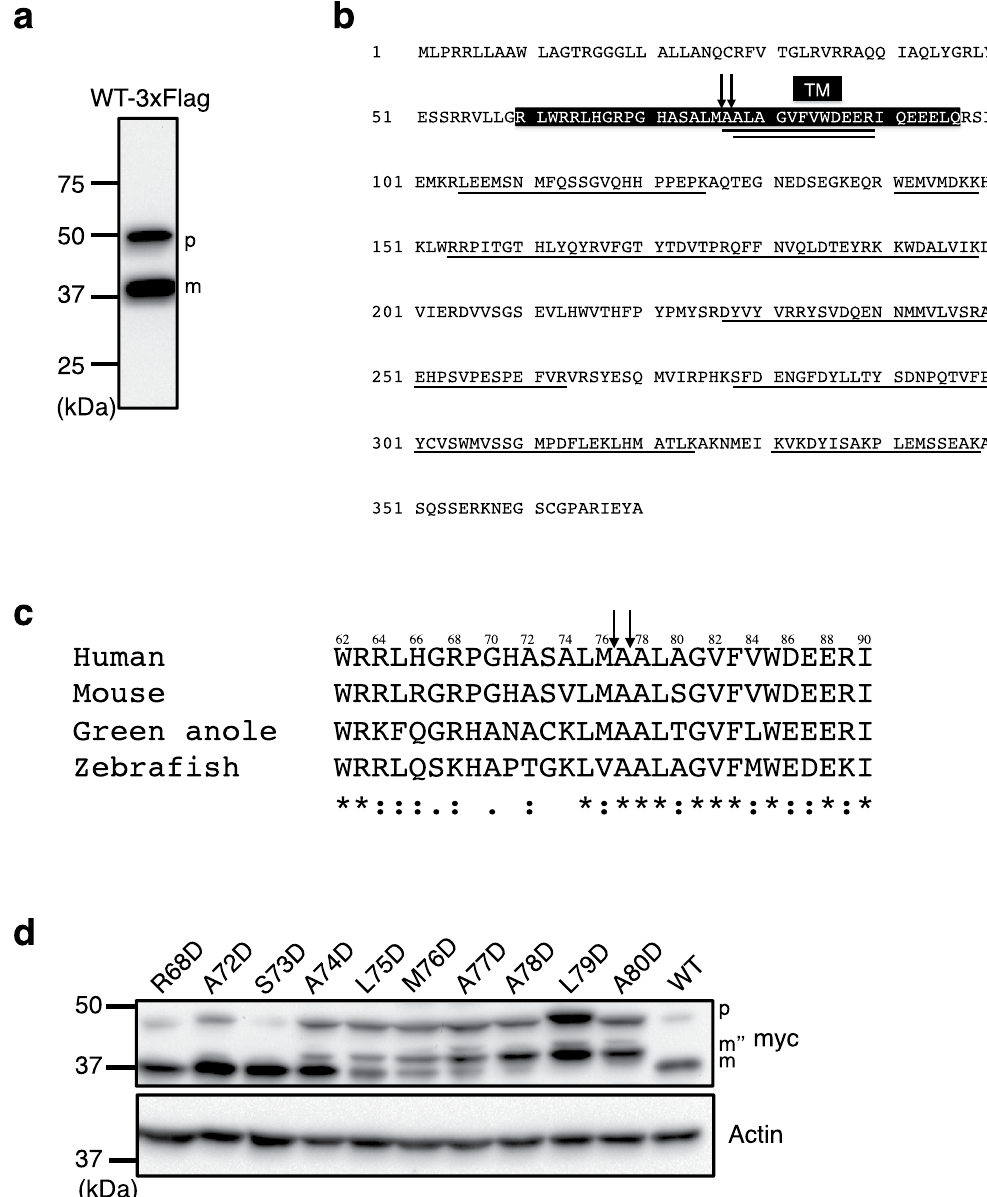
Figure 7. Determination of the cleavage site in the TM domain of StarD7 after integration into the mitochondrial membrane. ( a ) HEPA-1 cells were transfected with a plasmid encoding human StarD7 fused with the 3xFlag tag at the C-terminus. After lysing the cells, StarD7 was affinity purified using anti-Flag antibody conjugated to beads and analyzed with Western blotting using anti-Flag antibody. p and m indicate the precursor and mature forms of the protein, respectively. ( b ) The protein band corresponding to the mature form was excised and analyzed by LC/MS/MS. The identified sequences are underlined . The TM domain (Arg 60 - Gln 96 ) is indicated by white letters in a black box . Arrows indicate possible cleavage sites. ( c ) Sequence alignment of StarD7 protein around the cleavage site in the TM domain. Asterisks indicate identical amino acids, and chemically similar amino acids are indicated by either two dots (very similar) or one dot (similar). ( d ) Amino acids around the cleavage site of StarD7 (Arg 68 , Ala 72 , Ser 73 , Ala 74 , Leu 75 , Met 76 , Ala 77 , Ala 78 , Leu 79 , or Ala 80 ) were individually mutated to an aspartic acid, fused with myc-tag at the C-terminus, and expressed in HEPA-1 cells. Cell lysates were subjected to SDS-PAGE and immunoblotting using antibodies against myc and actin. m” and m indicate first-step and second-step cleaved StarD7, respectively. Actin was used as a protein loading